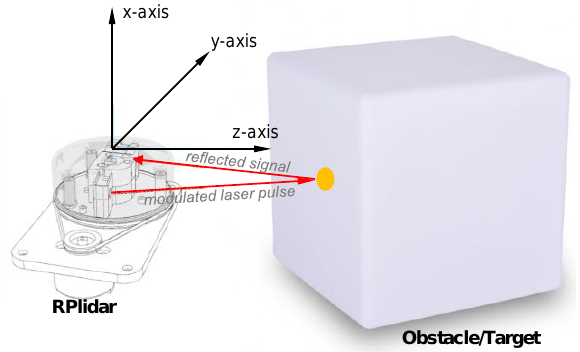
Figure 5. Laser triangulation principle.